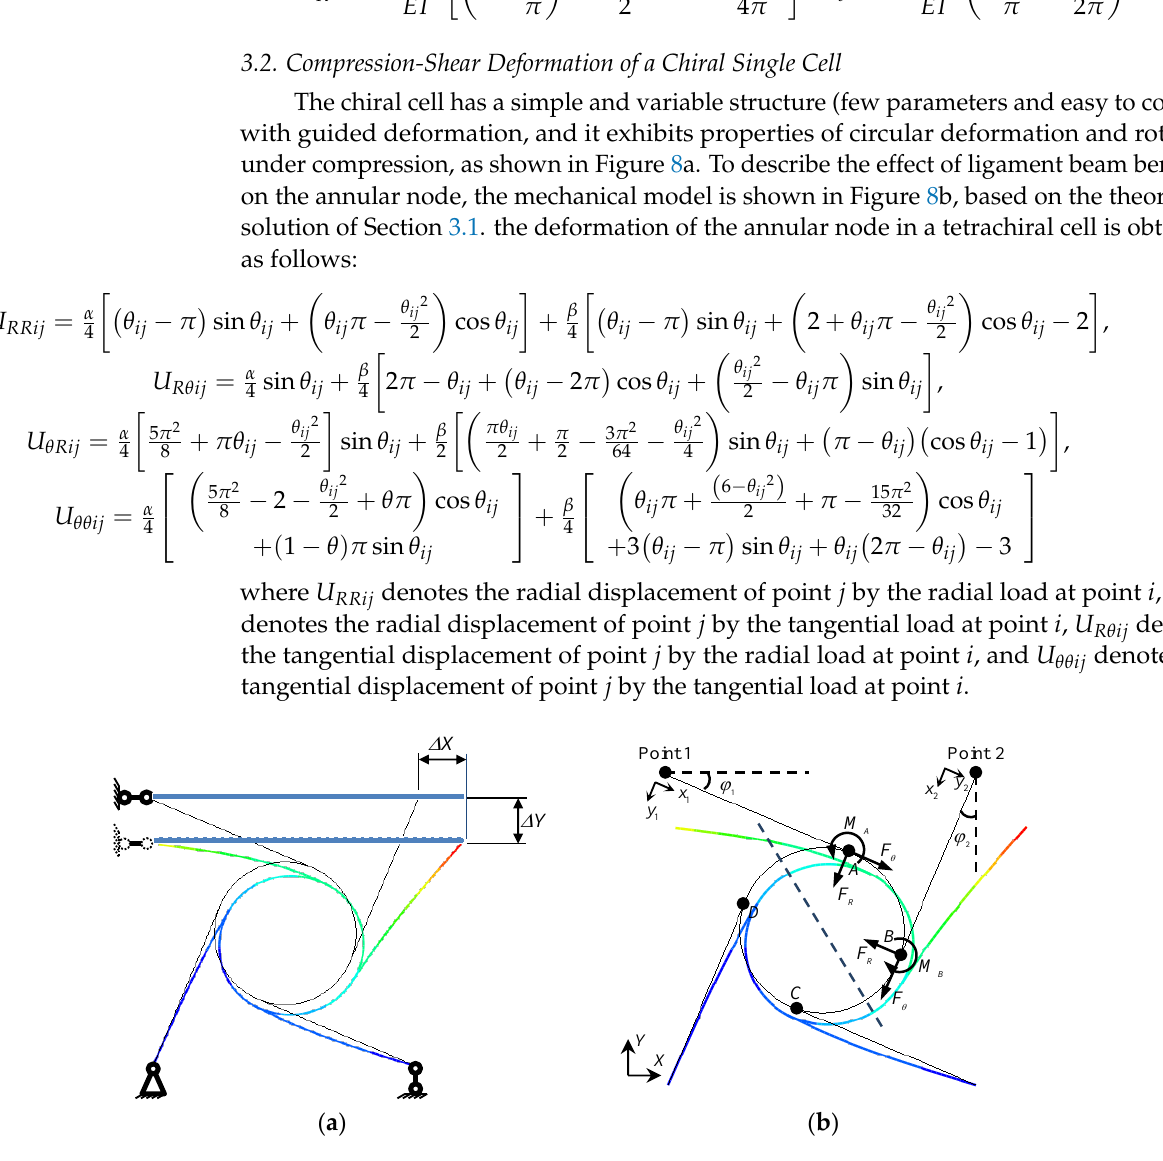
Figure 8. A schematic diagram of a tetrachiral cell. ( a ) Single-cell displacement and constraint; ( b ) A schematic diagram of the mechanics model for a chiral cell.